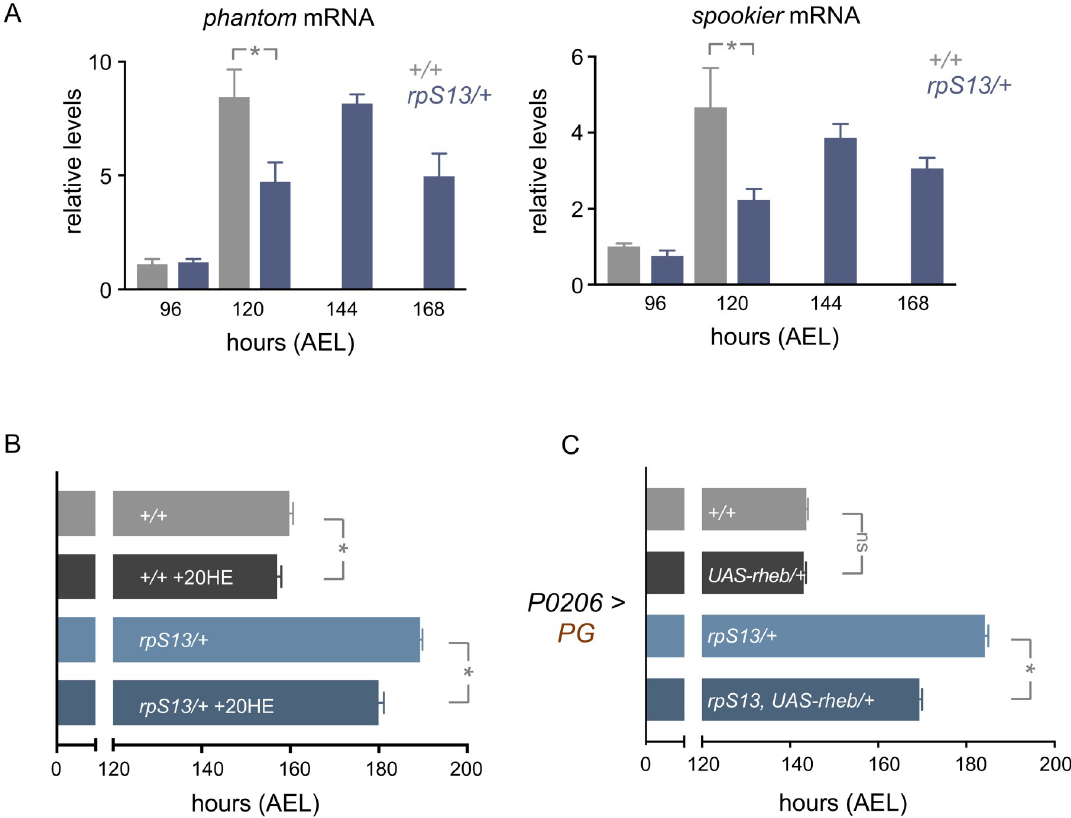
Fig 2. Delayed development in rpS13/+ animals is due to impaired ecdysone production. (A) qRT-PCR measurements of phantom and spookier mRNA levels in w 1118 and rpS13/+ larvae. n = 4 independent samples per genotype. Data are presented as +/- SEM. � p < 0.05, two-way ANOVA and post-hoc Student’s t-test. (B) Time to pupation of w 1118 and rpS13/+ larvae grown in control food or food supplemented with ecdysone (20HE). Data are presented as +/- SEM. � p < 0.05, Mann-Whitney U test. n = 142 ( +/+ ), 92 ( +/+ with 20HE), 148 ( rpS13/+ ), 116 ( rpS13/+ with 20HE). (C) Time to pupation of +/+ and rpS13/+ larvae with or without UAS-rheb expression in the prothoracic gland using P0206-Gal4 . Data are presented as +/- SEM. ns = not significant, � p < 0.05, Mann-Whitney U test. n = 152 ( +/ +), 157 ( UAS-rheb/+ ), 151 ( rpS13/+ ), 144 ( UAS-rheb/rpS13